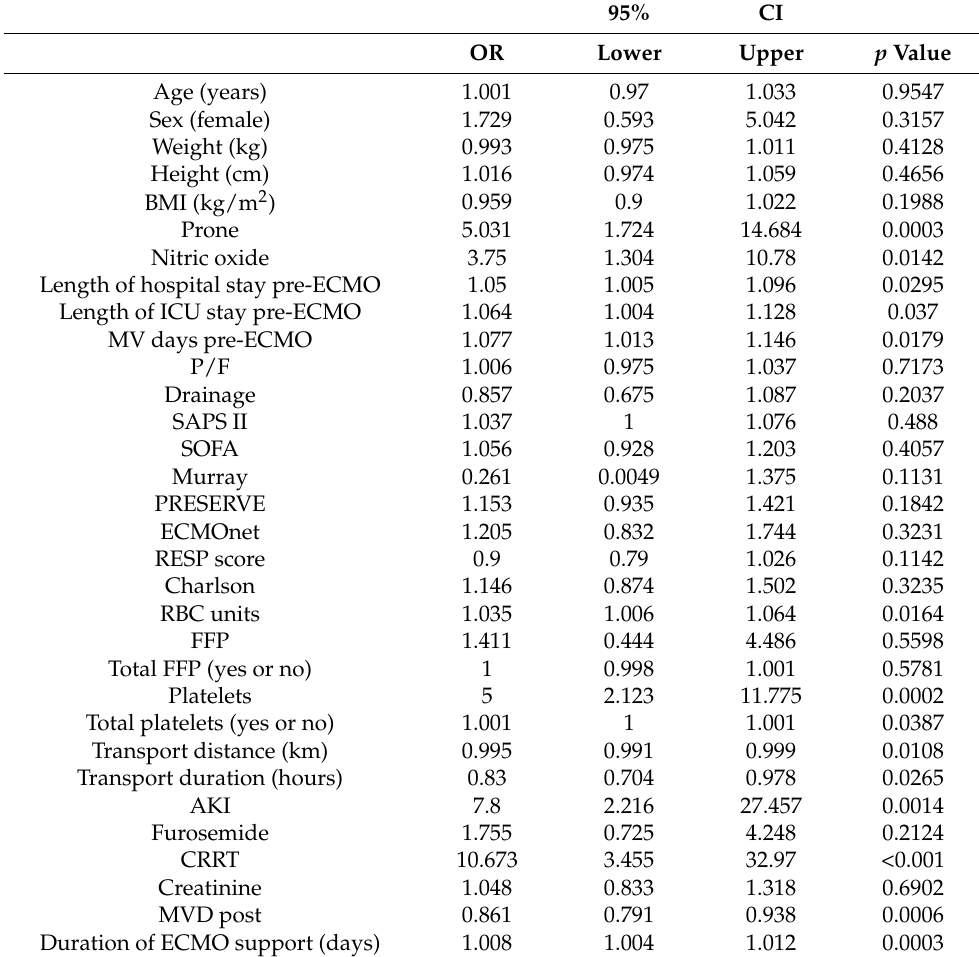
Table 3. Logistic regression of the association between predictive factors and